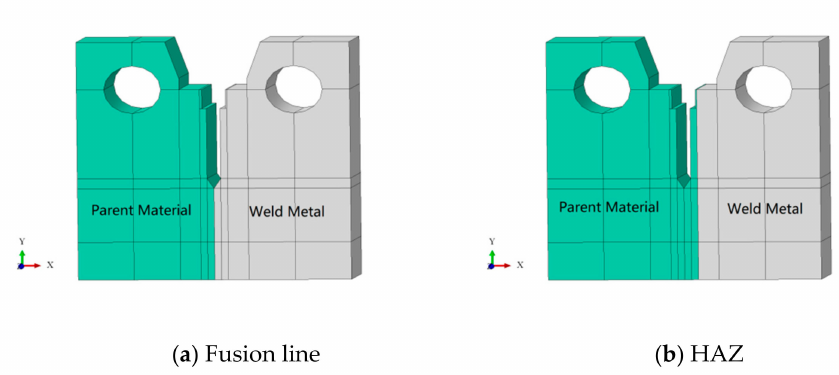
Figure 13. The dissimilar material XFEM models. ( a ) Fusion line; ( b ) HAZ.